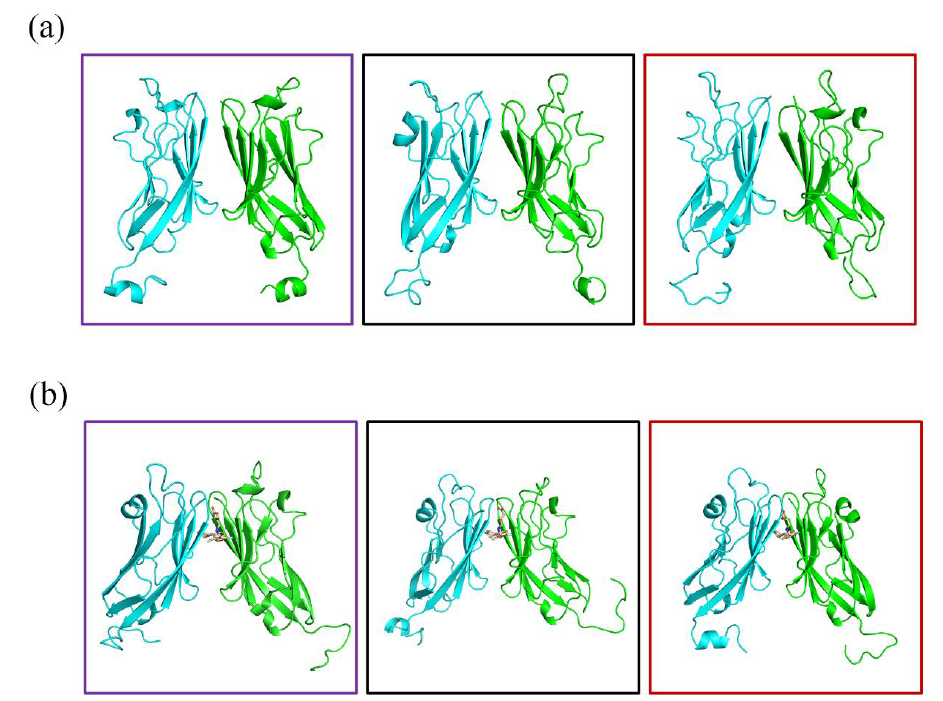
Figure 8. Structural dynamics of the ( a ) dimer and ( b ) S systems over the 150 ns MD simulation period. Violet boxes show the starting structures averaged at 0–50 ns, black boxes show averaged intermediate structures at 50–100 ns, while red boxes show the averaged end structures at 100–150 ns.